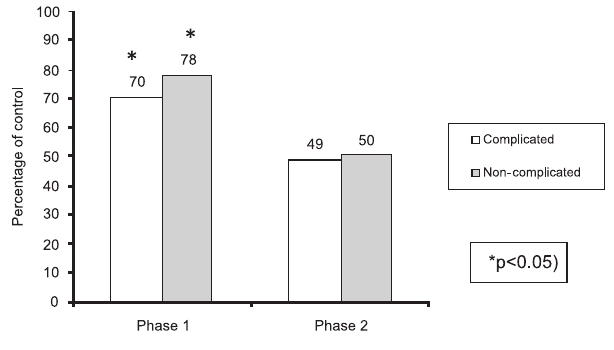
Figure 1 - Blood pressure control in hypertensive patients with and without complications, according to phase of